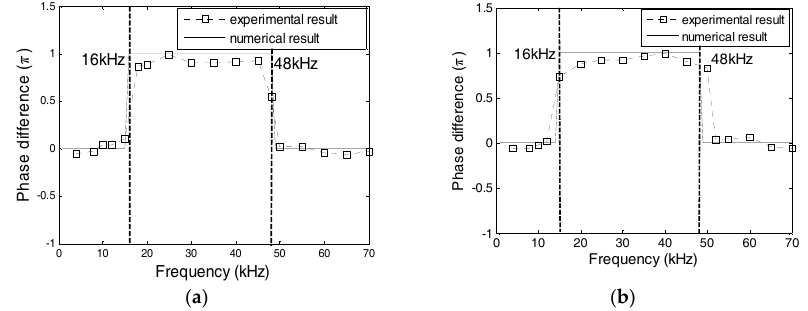
Figure 19. Phase difference between PZT transducers from Specimens 3 and 4. ( a ) Specimen 3; ( b ) Specimen 4.